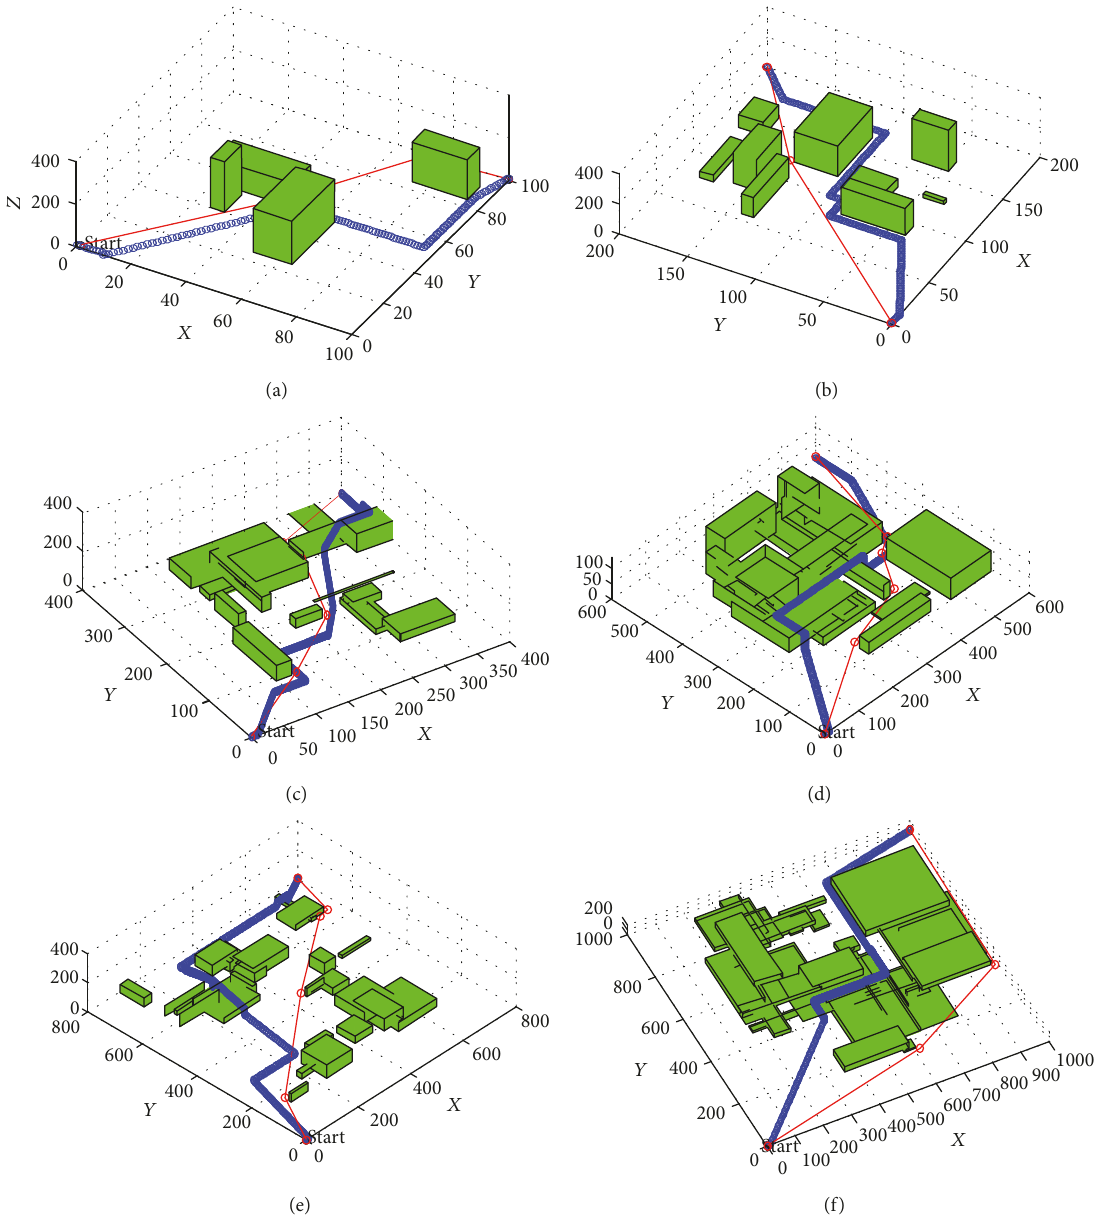
Figure 10: Simulation of two path fi nding algorithms: (a) 5 obstacles; (b) 10 obstacles; (c) 15 obstacles; (d) 20 obstacles; (e) 25 obstacles; (f) 30 obstacles. Table 4: Simulation results based on number of